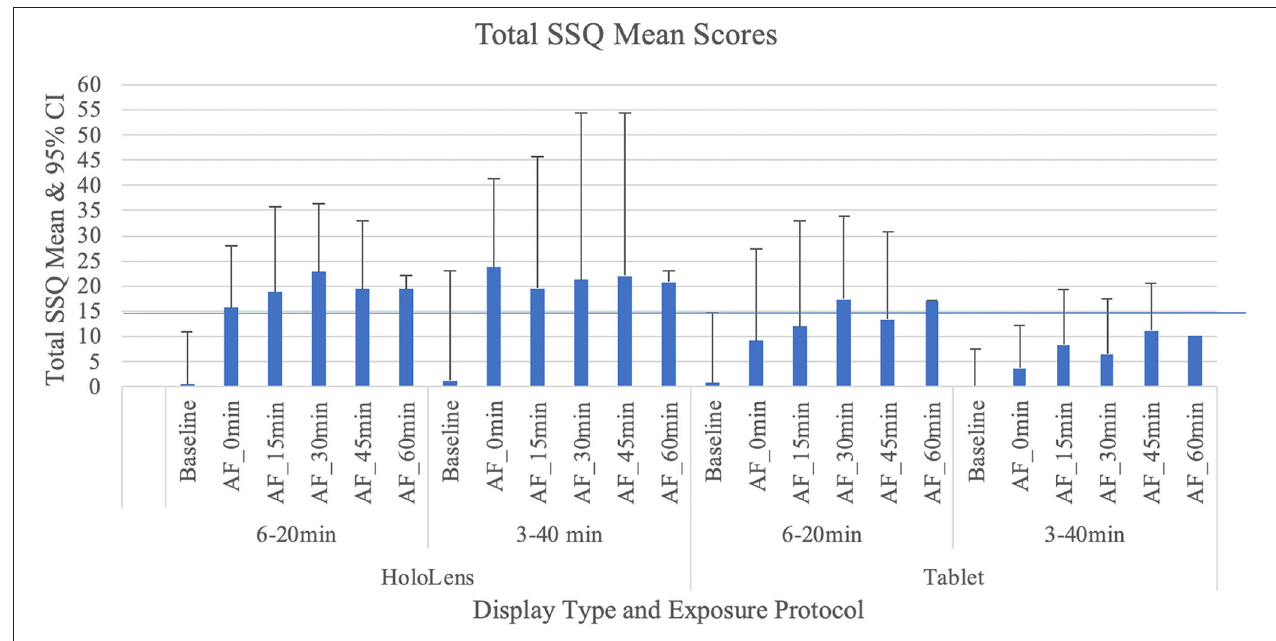
FIGURE 2 | Total SSQ mean scores and 95% confidence interval.